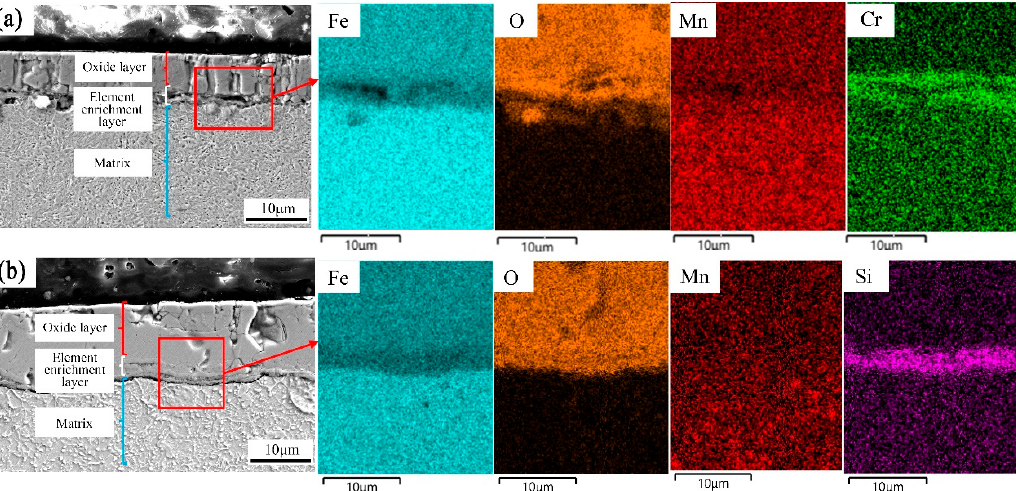
Figure 5. Scanning electron microscope images and energy spectrum composition analysis of sample sections after friction, ( a ) 10Mn5 steel; ( b ) 22MnB5 steel.